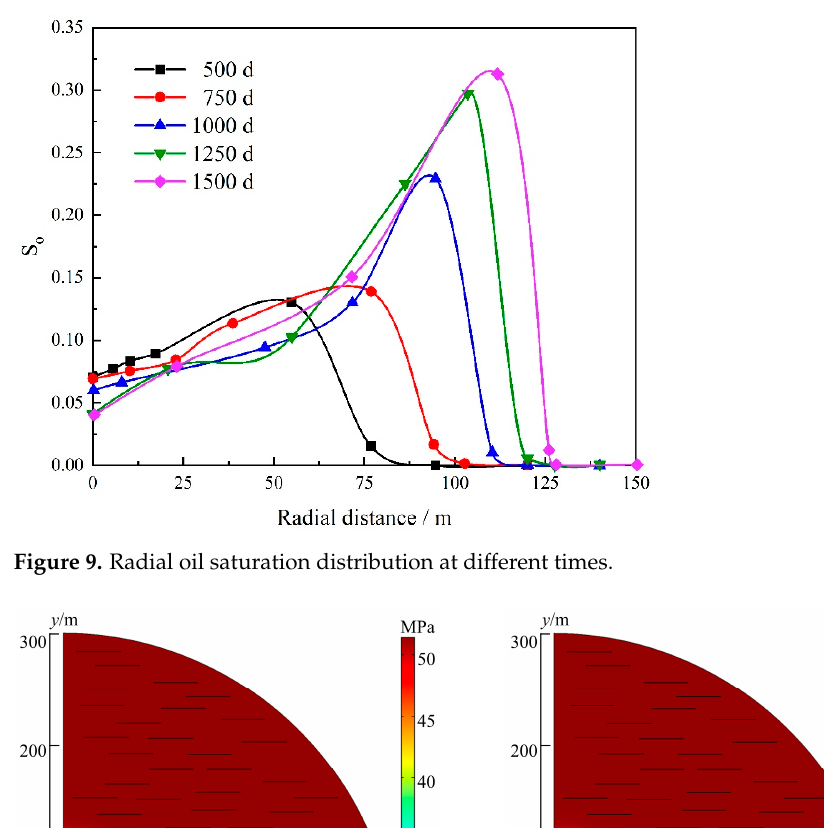
Figure 9. Radial oil saturation distribution at different times.